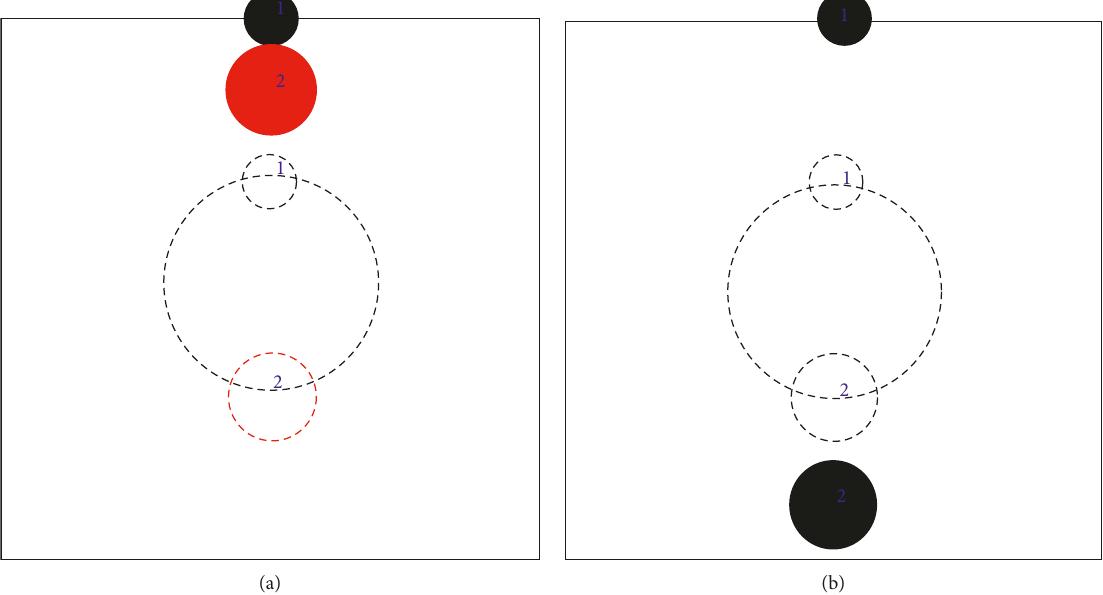
Figure 4: The initial position of two particles is initially equispaced on a circle with θ along x direction, and the final particle chains after DEP interaction under different status: (a) two heterogeneous particles with different diameters, (b) two negative DEP particles with different